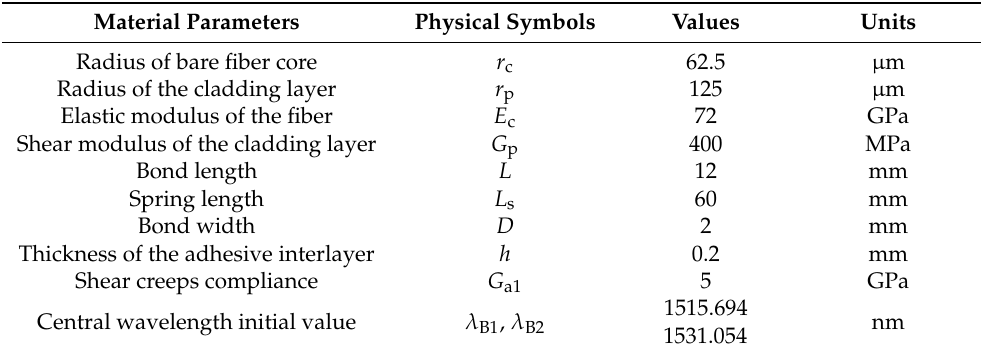
Table 1. The physical and mechanical parameters of the experimental